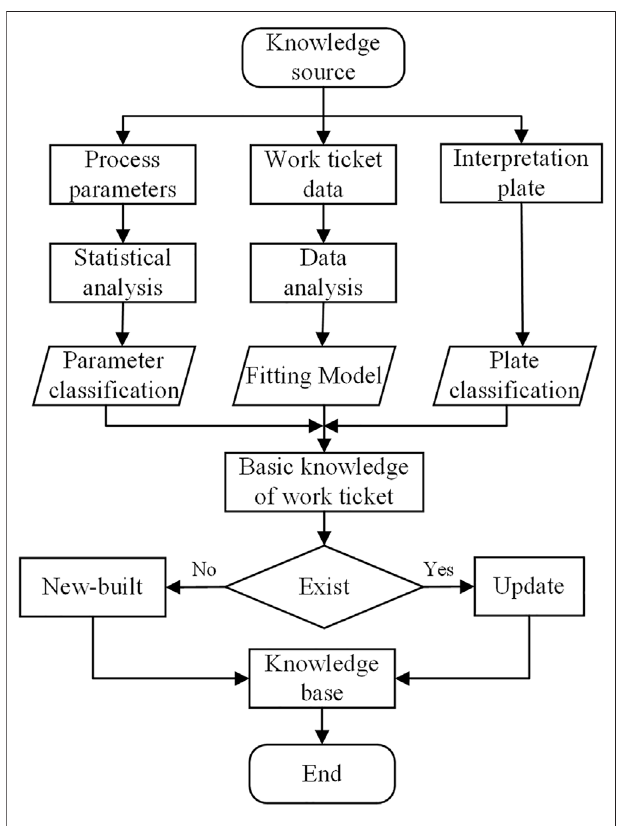
FIGURE 3 | Knowledge base establishment